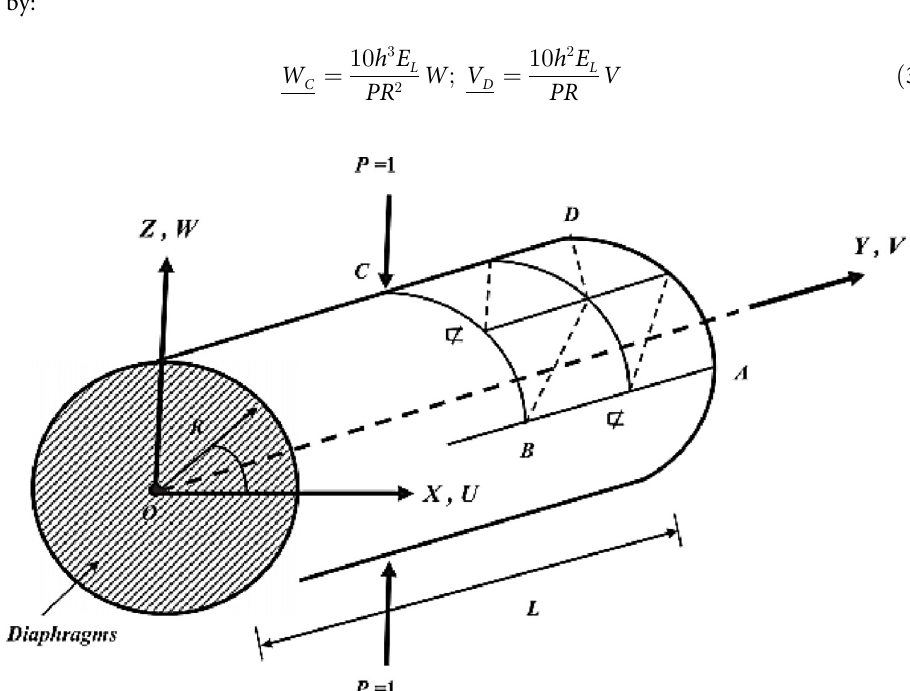
Fig 10. Pinched cylindrical laminate shell with rigid diaphragm at the